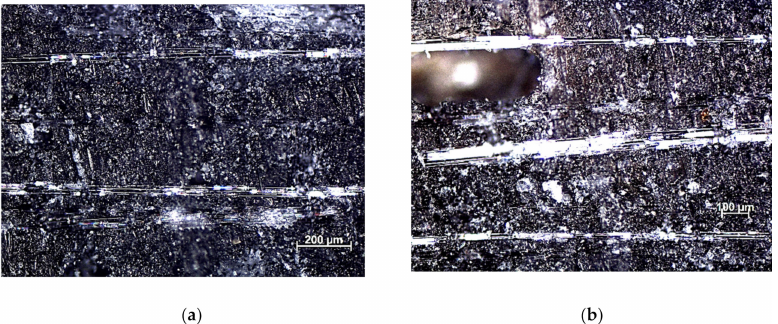
Figure 7. Composite structures: ( a ) without recyclate, ( b ) 10% of recyclate, magnification × 100.